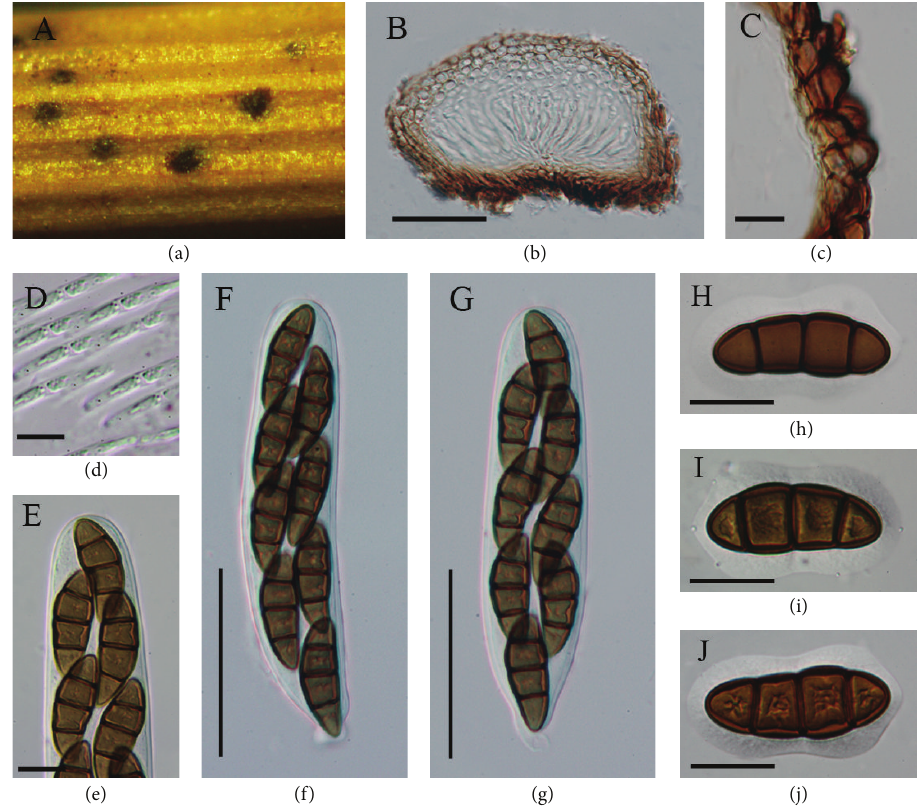
Figure 2: Diadema tetramerum (holotype). (a) Ascomata on substrate opening via a flat circular lid. (b) Vertical section of ascoma. (c) Closeup of the peridium. (d) Hyaline, septate pseudoparaphyses. (e) Apical part of the asci, ((f)-(g)) Asci with short orbicular pedicel. ((h)– (j)) Reddish-brown ascospores with broad sheath. Scale bars: (b) = 100 𝜇 m, (c) = 10 𝜇 m, ((d)–(g)) = 60 𝜇 m, and ((h)–(j)) = 30 𝜇 m.